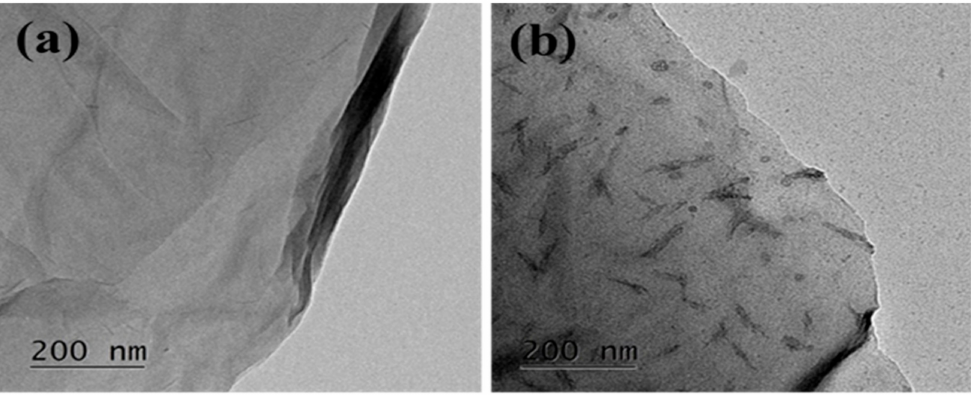
Figure 3. FE-TEM images of ( a ) GO and ( b ) HMTA-GO.